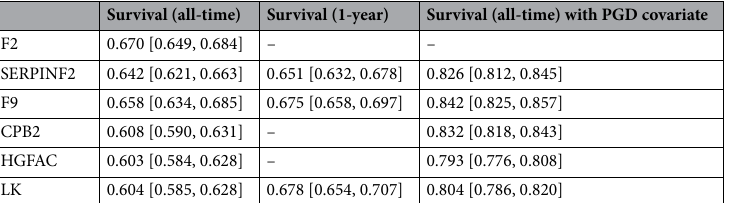
Normalized enrichment score False discovery